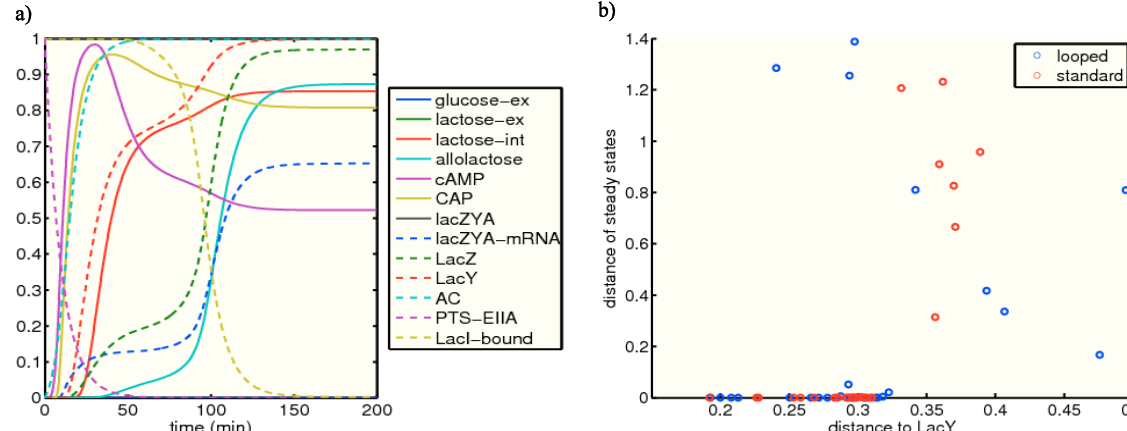
Figure 8: Simulations with the “looped model”. The looped model was derived from a multivalued logical model that accounts for the negative effect of the lactose metabolism on the cAMP level (the arc AC cAMP in the non-looped (“standard”) model in figure 3 is replaced by the hyperarc AC !lactose_int cAMP). a) Simulations of the looped ODE Model. In contrast to figure 4b, the cAMP level increases during the transition from glucose to lactose utilization but decreases again when this shift has been accomplished. b): Potential of the looped and non-looped model to show bistability. Bistable behavior is quantified as the distance of the two steady states reached when growing on low lactose levels (0.2 in the ODEfy model) after preculturing either on lactose or glucose (the distance is zero if only one steady state exists). In both the standard and the looped model, we can identify parameters that fit the data (low distance to LacY) and also exhibit strong bistable behavior. The current sampling methods are not sufficient to differentiate these two